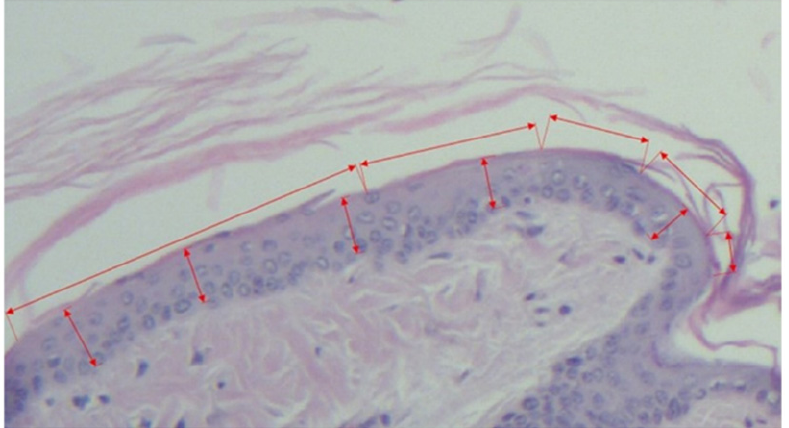
Figure 1. Negative control group section (untreated mice), hematoxylin–eosin staining, 10× objec- tive.